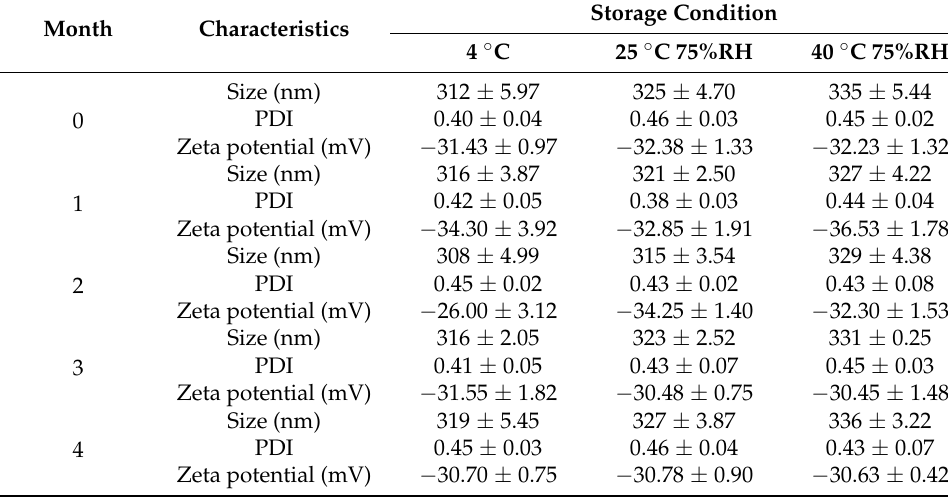
Table 5. The size, PDI, and ZP of FLP stored at 4, 25, and 40 ◦ C, 75%RH for 4 months ( n =